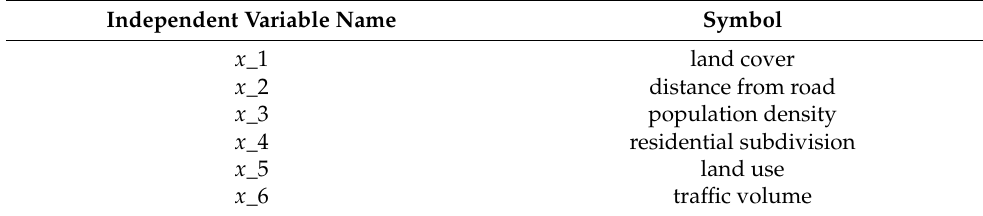
Table 1. List of independent variables used in Equation